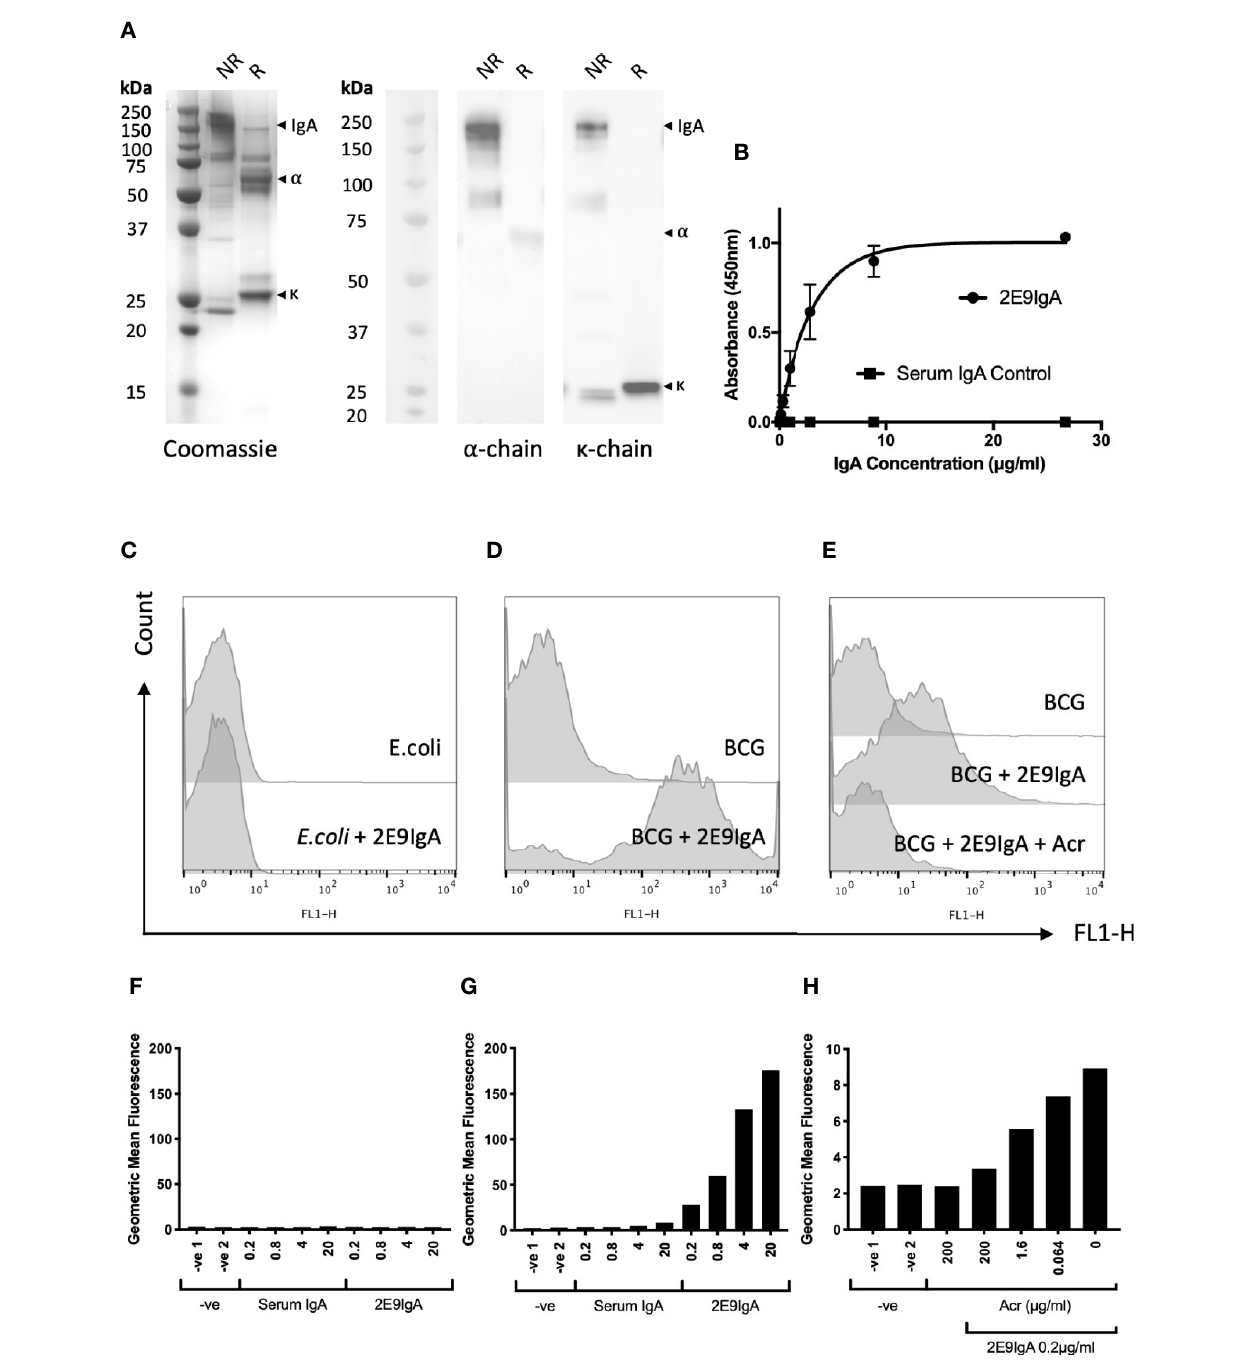
FIGURE 1 | Biophysical characterisation of 2E9IgA1. SDS-PAGE Coomassie and Western blot (A) were performed under non-reducing (NR) and reducing (R) conditions. a and k chains were detected using HRP conjugated anti-human a and k chain secondary antibodies and developed with ECL prime substrate. 2E9IgA1 binding to puri fi ed recombinant Acr antigen was investigated by ELISA (B) with error bars indicating SEM. Binding of 2E9IgA1 to (E) coli (C , F) and BCG (D , G) was investigated by fl ow cytometry using an anti-human IgA ( a -chain) FITC conjugated antibody and acquired on a BD FACSCalibur. Antigen speci fi city of 2E9IgA1 binding to BCG was performed by an Acr competition assay prior to data acquisition by fl ow cytometry (E , H) . Experiment performed two times, with similar